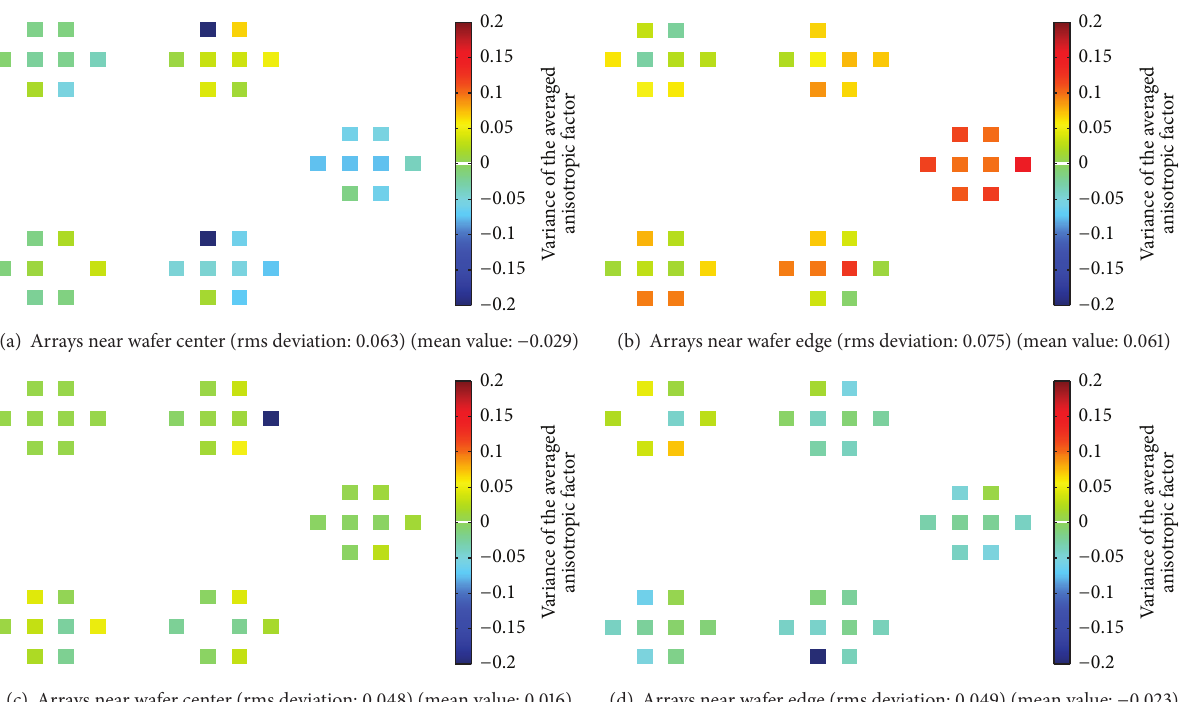
Figure 7: Variation of the anisotropic factor from the averaged value of anisotropy on the quarter at different etch parameters: (a) and (b) 90 mTorr, 60 s, 90 W, (c) and (d) 50 mTorr, 90 s, 90 W. Values in brackets are the root mean square deviation and the arithmetic mean of the